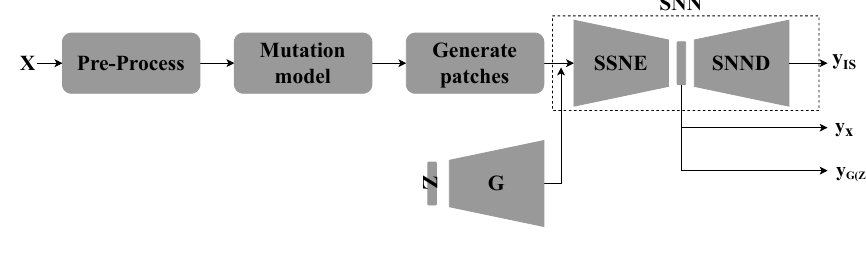
Figure 3. Presents the proposed end-to-end